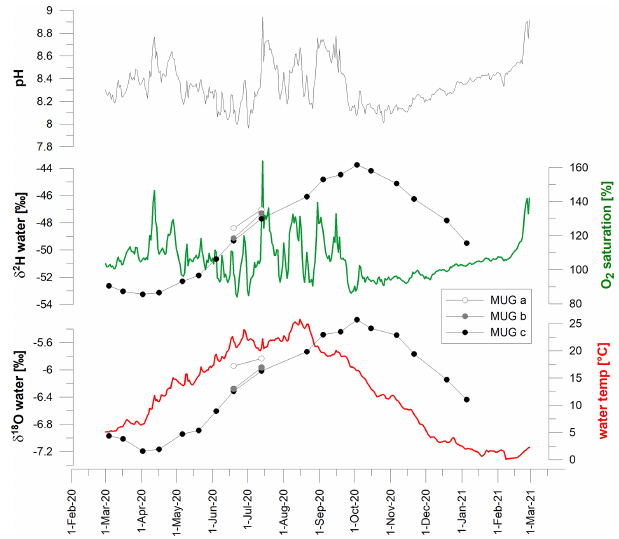
Figure 4. Time series of δ 2 H and δ 18 O values from the samples taken in 2–4-week intervals (March 2020–January 2021) at the out- flow of Müggelsee (MUG c: Friedrichshagen harbor) and from ad- ditional samples taken on the northern shore (MUG a and b) on 19 June and 13 July. Water chemical and physical data are daily averages derived from the IGB long-term monitoring station (IGB,